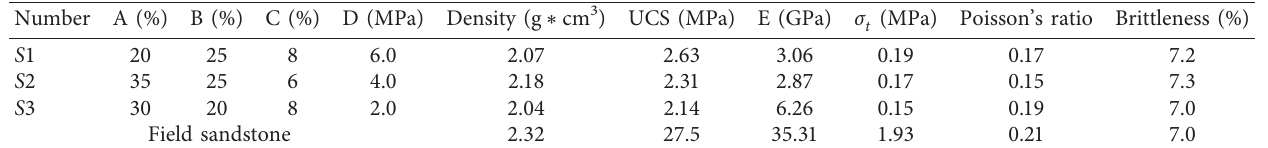
Table 1: Proportion and mechanical parameters of the sample.